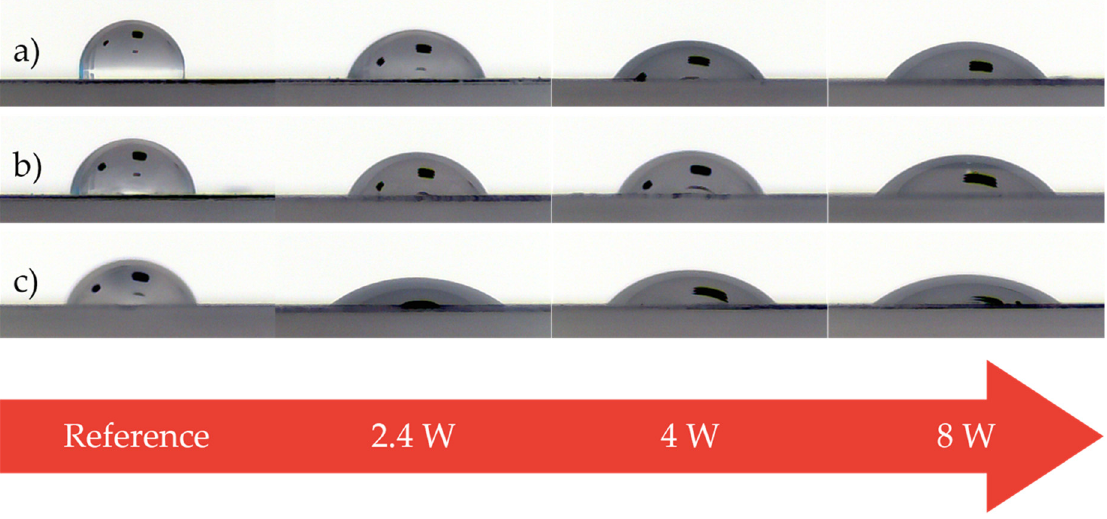
Table 4. Wetting contact angles of PP materials (depending on radiation dose).